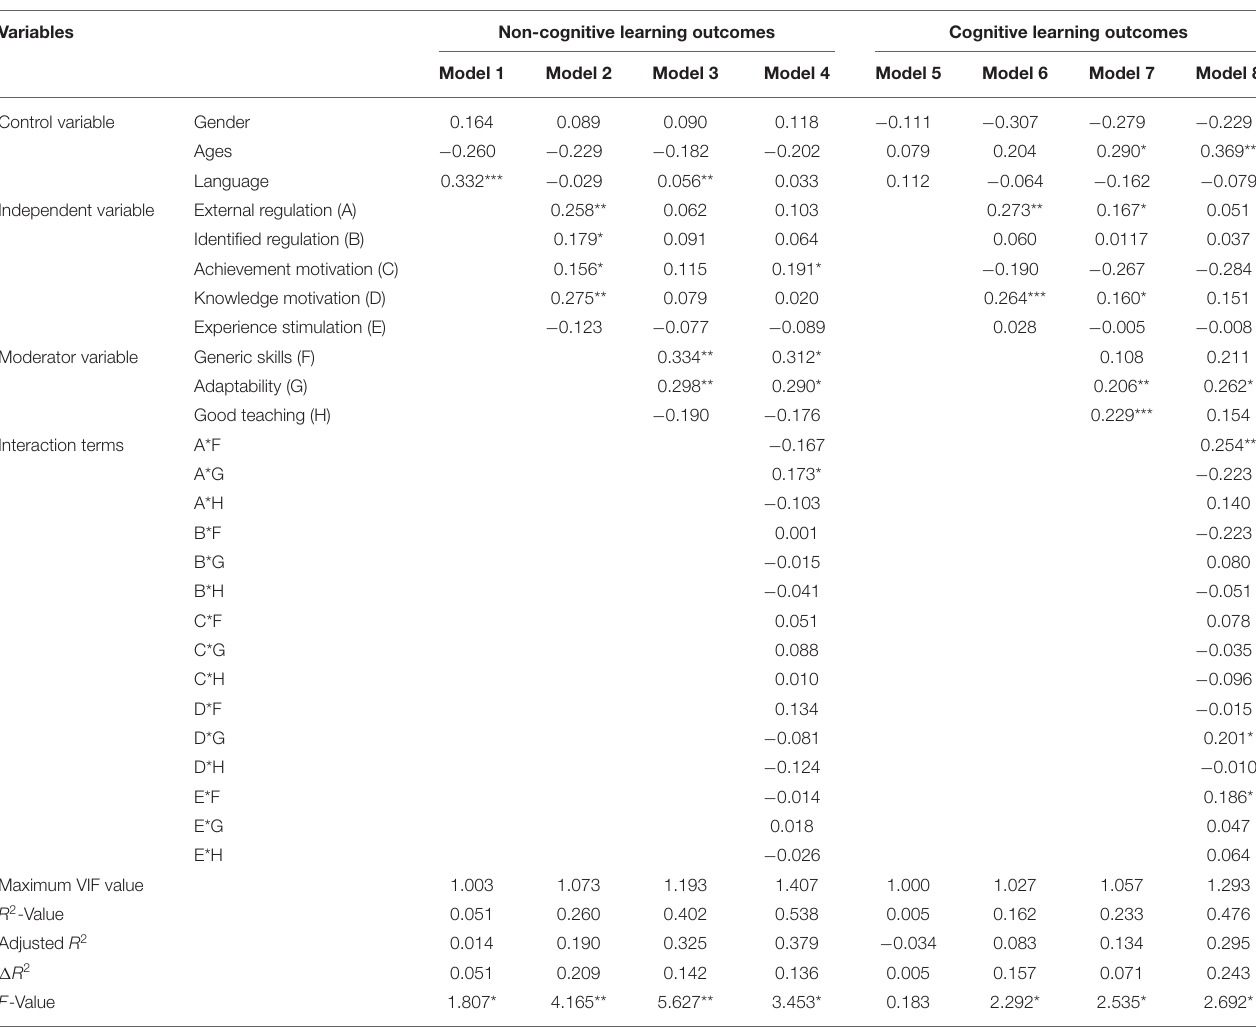
TABLE 4 | Regression analysis